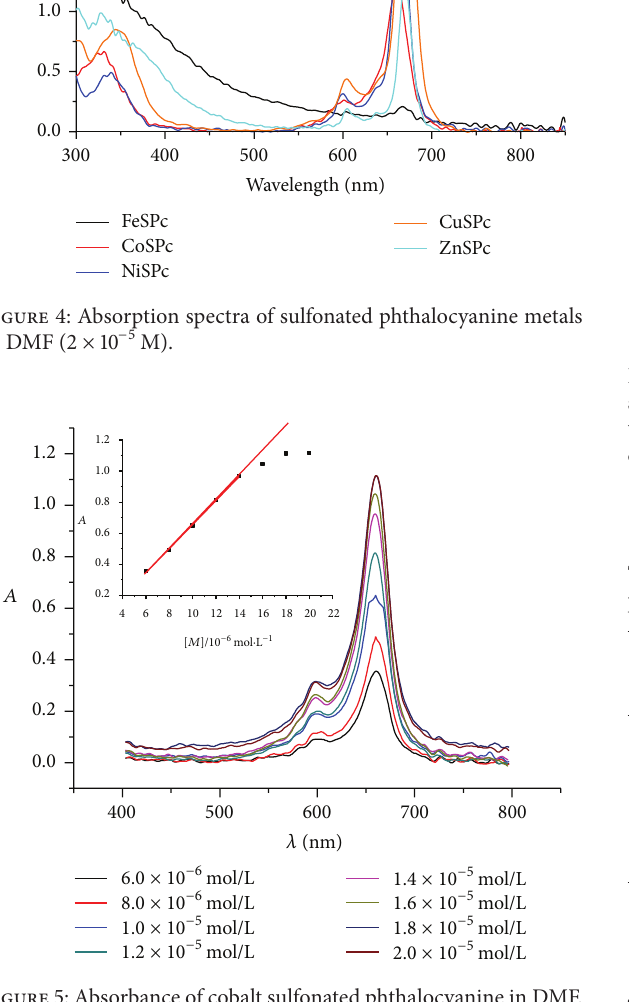
Figure 5: Absorbance of cobalt sulfonated phthalocyanine in DMF. (The inset is the relationship between the absorbance at maximum absorption wavelength and the concentration.)